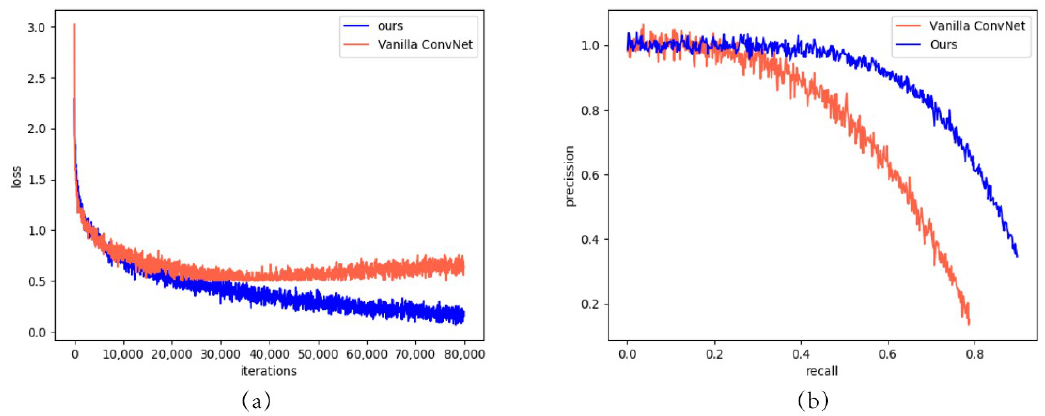
Figure 6. D-F Net performance compared with the vanilla ConvNet: ( a ) Loss function curve of 80,000 iterations; ( b ) precision–recall curve.